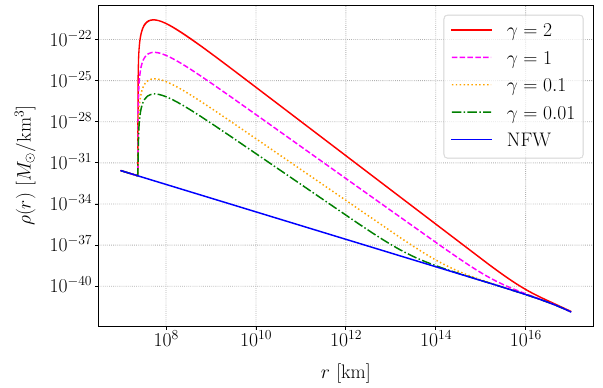
Fig. 1 Dark-matter density profile as a function of radius. Depicted are a pure NFW profile as well as the onset of the spike density profiles Eq. (4) with γ = 0 . 1 , 1 , 2 (bottom to top) for M = M SgrA